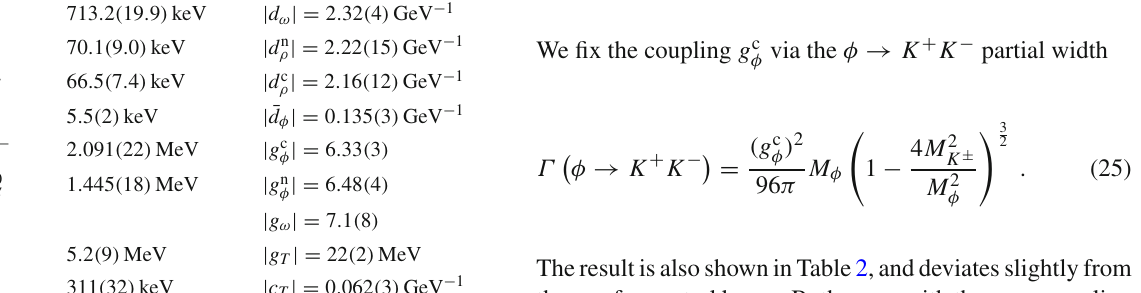
Table 2 The absolute values of the coupling constants required for the tree-level resonance exchange calculations are determined via the partial widths [78] of the corresponding two-body decays Partial width Coupling